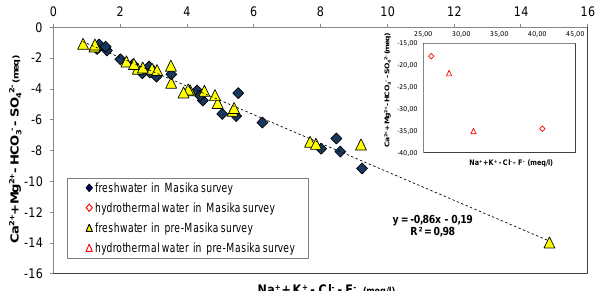
Fig. 13. A Ca-Mg-alkalinity-SO 4 vs. Na-K-Cl-F scatter diagram il- lustrates the occurrence of ion exchange. The dotted line represents the 1:1 ratio.